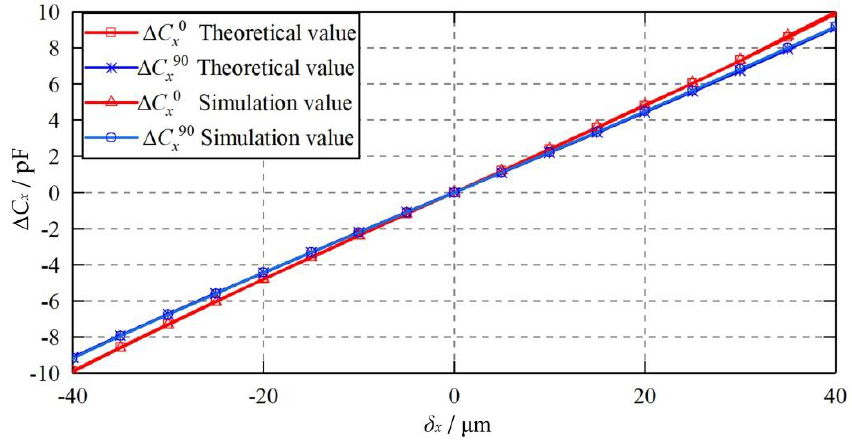
Figure 9. Dependence of the di ff erential capacitance ∆ C x on the eccentric displacement of the ellipsoidal ball.